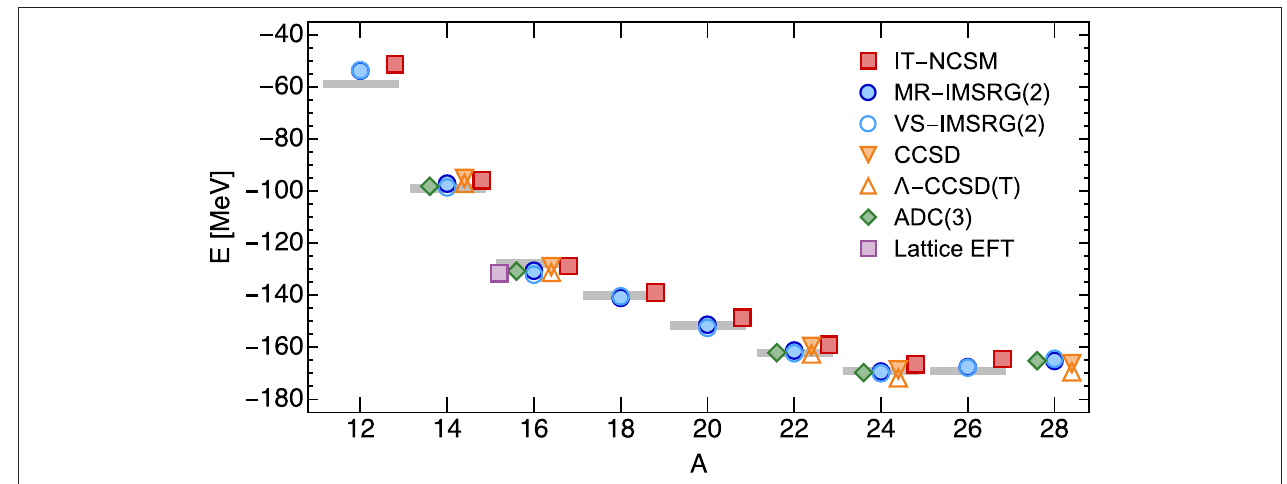
FIGURE 5 | Ground-state energies of the oxygen isotopes for various many-body approaches, using the chiral NN+3N(400) interaction at λ = 1.88fm − 1 [ 183]. Details on the Lattice EFT calculation can be found in reference [ 177]. Gray bars indicate experimental data [184].